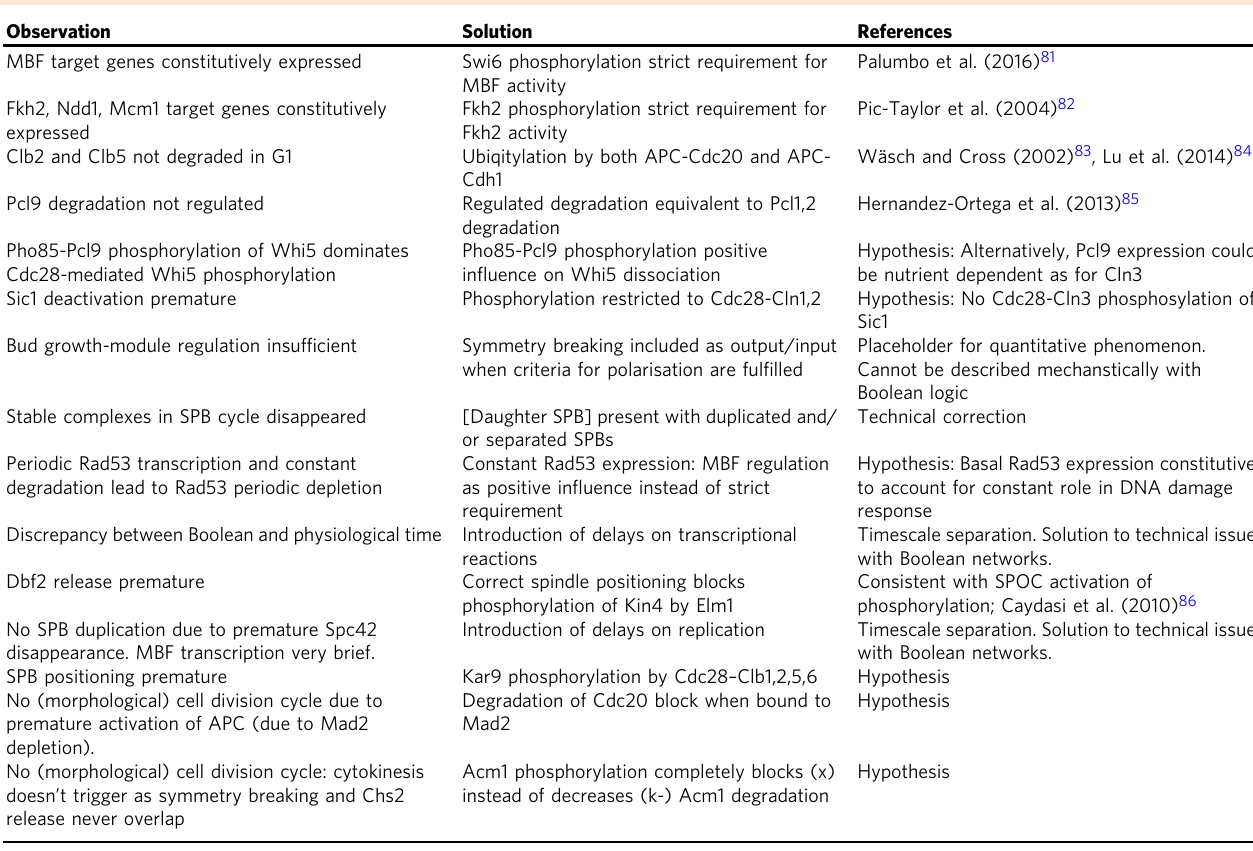
Table 1 List of gap- fi lling